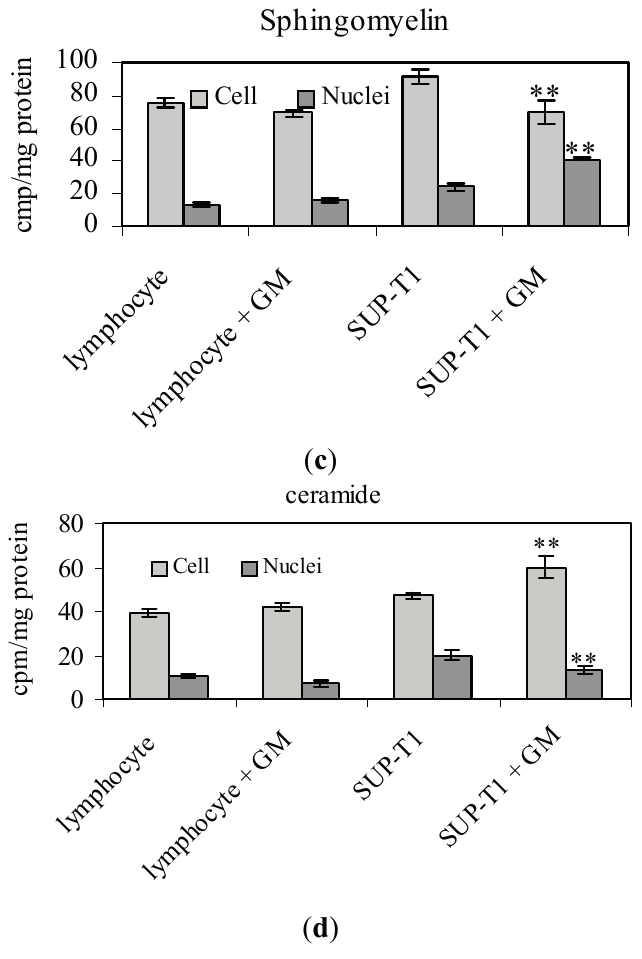
Figure 3. Effect of gentamicin on lipid metabolism in lymphocytes and SUP-T1 cells and in their purified nuclei. The enzyme activity of phosphatidylcholine-dependent phospholipase C (PC-PLC), sphingomyelinase (SMase), sphingomyelin-synthase (SM-synthase) in whole cells ( a ) and in purified nuclei ( b ); 3 H-palmitic acid incorporation in cells and nuclear sphingomyelin ( c ); 3 H-palmitic acid incorporation in cells and nuclear ceramide ( d ). Data are expressed as the mean ± SD of three independent experiments performed in duplicate. ** p <